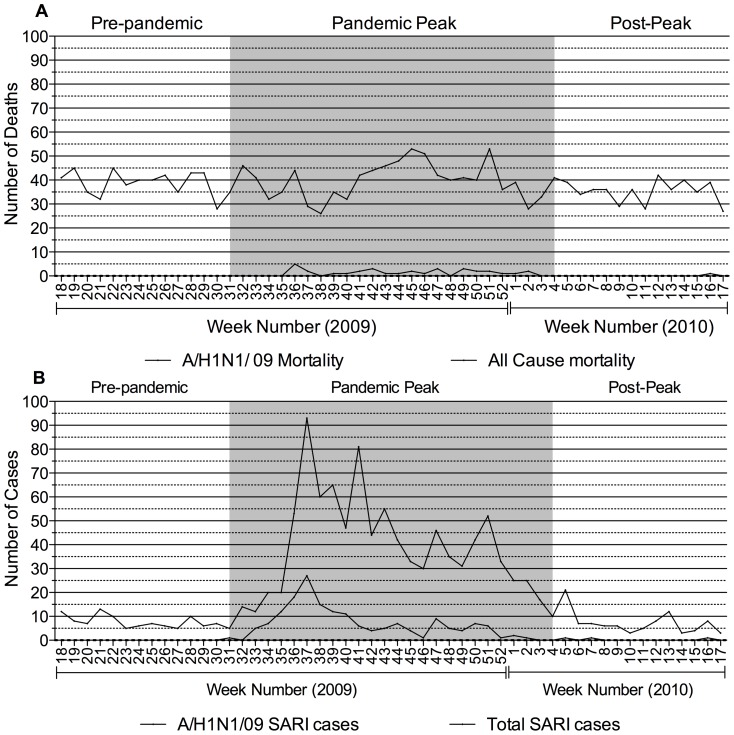
Weekly trend of Mortality and SARI admissions from May 2009 to April 2010.The figure represents the weekly numbers of Mortality and SARI admissions for the study period. A) Week-wise all cause mortality and A/H1N1/09 mortality. The peak mortality due to A/H1N1/09 was during 2009 week 36 (5 cases, 14% of all pandemic deaths). B) Week-wise total SARI admissions and A/H1N1/09 positive SARI admissions. Peak total SARI admissions occurred during 2009 week 37 (94 cases) while for A/H1N1/09 SARI admissions, this was seen at during week 37 (28 cases).